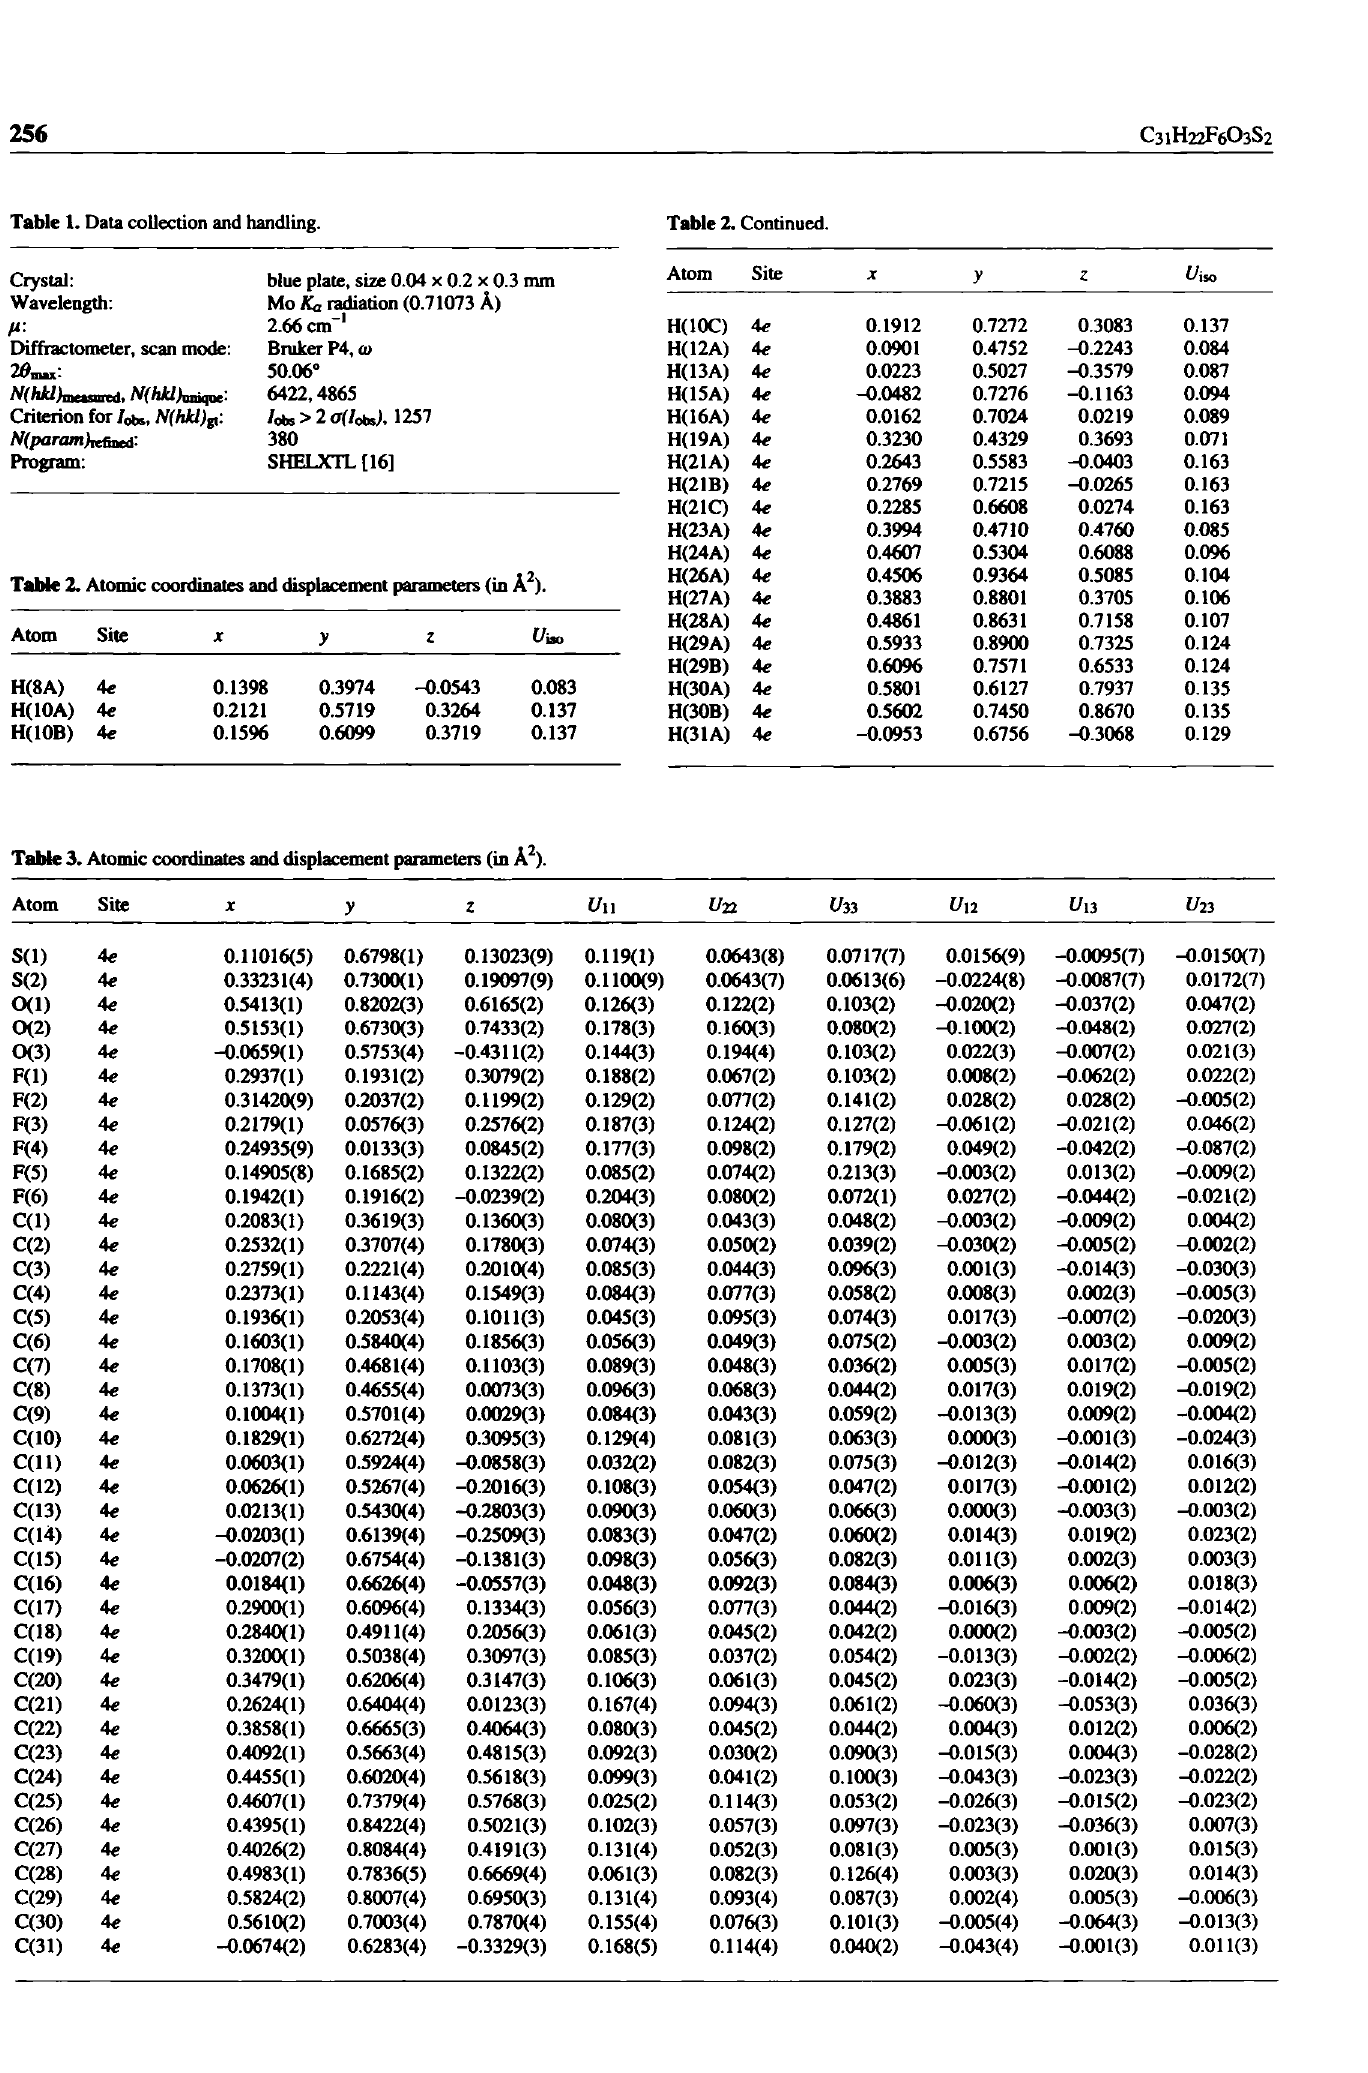
Table 2. Atomic coordinates and displacement parameters (in A 2 ).